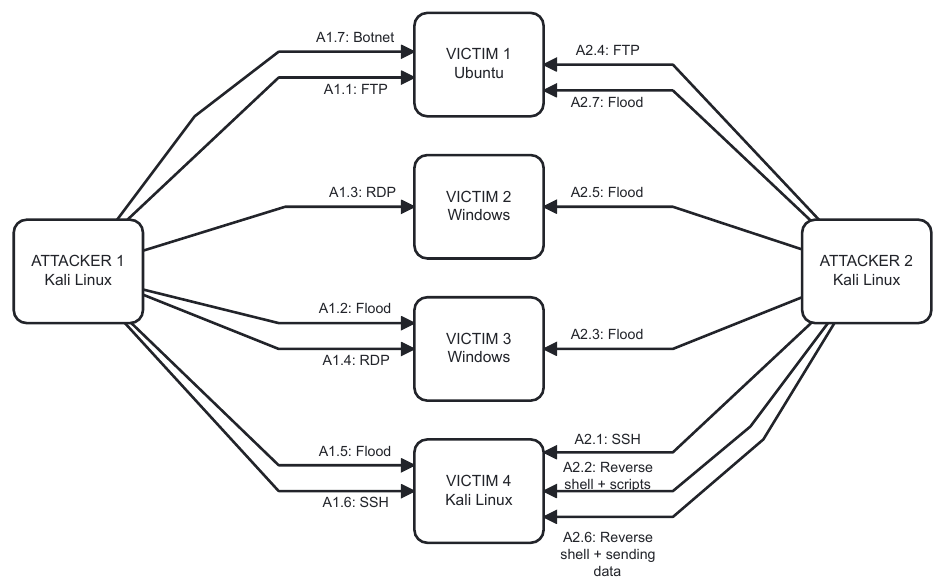
Figure 2. Diagram of the performed attacks presenting two attackers and four victims as well as planned attacks.